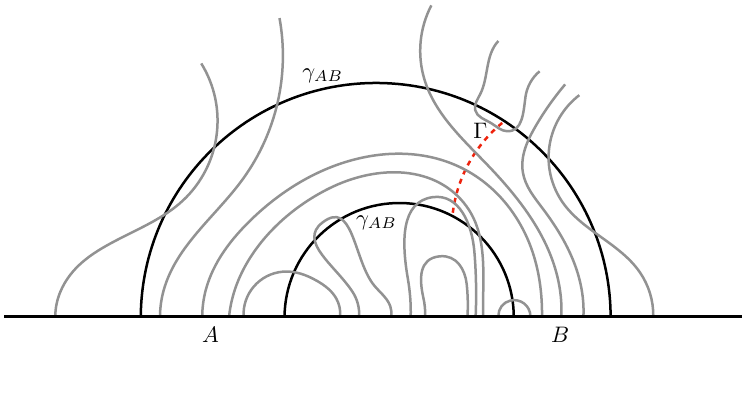
Figure 2 . Types of bit threads that can cross the RT surface, (cid:13) The properties that distinguish di(cid:11)erent types of bit threads are where they begin and end ( A , B , or ( AB ) c ), as well as how many times they intersect (cid:13) AB and the entanglement wedge cross section (cid:0) (red dashed